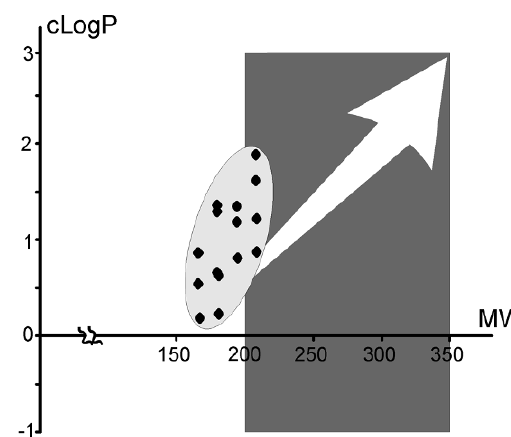
Figure 3. (cid:51)(cid:75)(cid:92)(cid:86)(cid:76)(cid:70)(cid:82)(cid:70)(cid:75)(cid:72)(cid:80)(cid:76)(cid:70)(cid:68)(cid:79)(cid:3) (cid:83)(cid:68)(cid:85)(cid:68)(cid:80)(cid:72)(cid:87)(cid:72)(cid:85)(cid:86)(cid:3) (cid:82)(cid:73)(cid:3) N -methyl derivatives of the amines 6 – 11 (black dots within the ellipse), shown together with the lead-likeness criteria as given by Churcher et al. [ (cid:24) ] (dark grey rectangle). The white arrow shows that there is much room for the design of compound